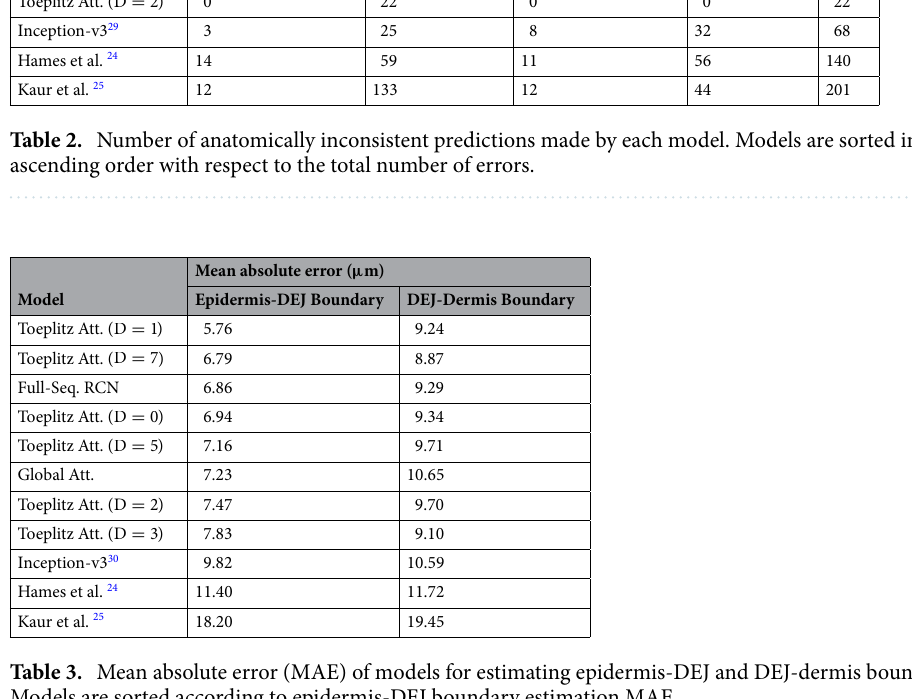
Error types Method TotalEpidermis → Dermis DEJ → Epidermis Dermis → Epidermis Dermis → DEJ Global Att. Toeplitz Att. ( D = 1 ) Toeplitz Att. ( D = 5 ) Toeplitz Att. ( D = 7 ) Full-Seq. RCN 29 Toeplitz Att. ( D = 3 ) Toeplitz Att. ( D = 0 ) 0 0 0 Toeplitz Att. ( D = 2 )